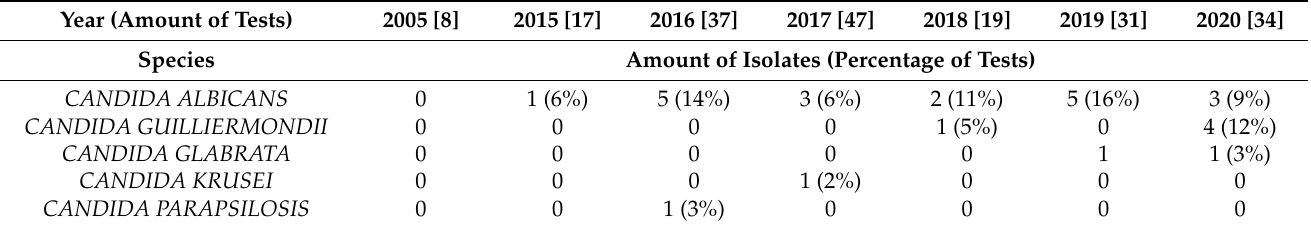
Table 6. Yeast species isolated in NICU patients from the lower respiratory